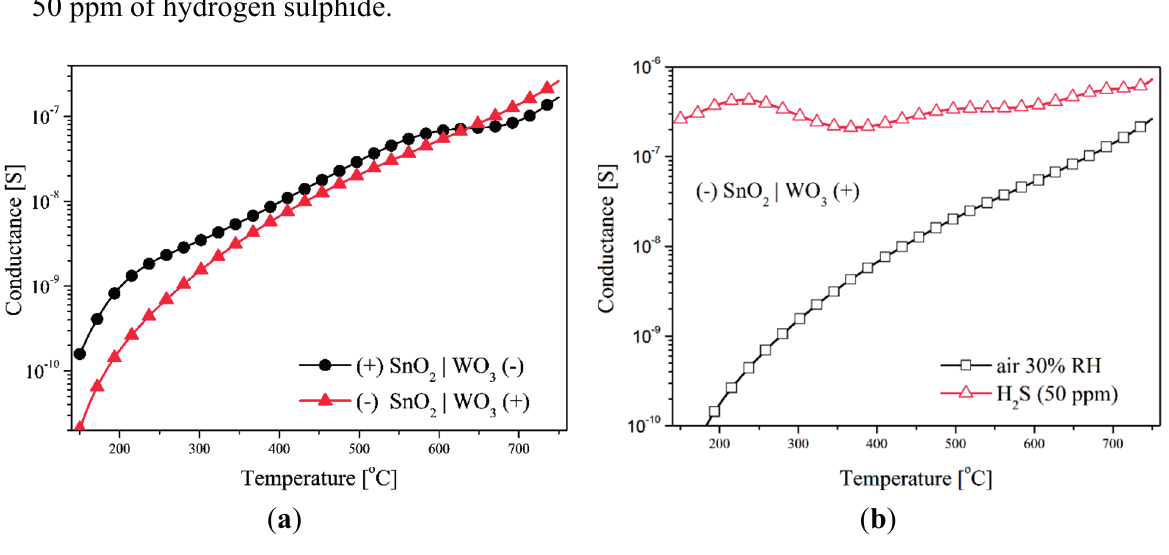
Figure 8. Temperature characteristics of TS-conductance of sensors with a heterocontact at various polarization directions in the atmosphere of: ( a ) synthetic air; ( b ) air containing 50 ppm of hydrogen